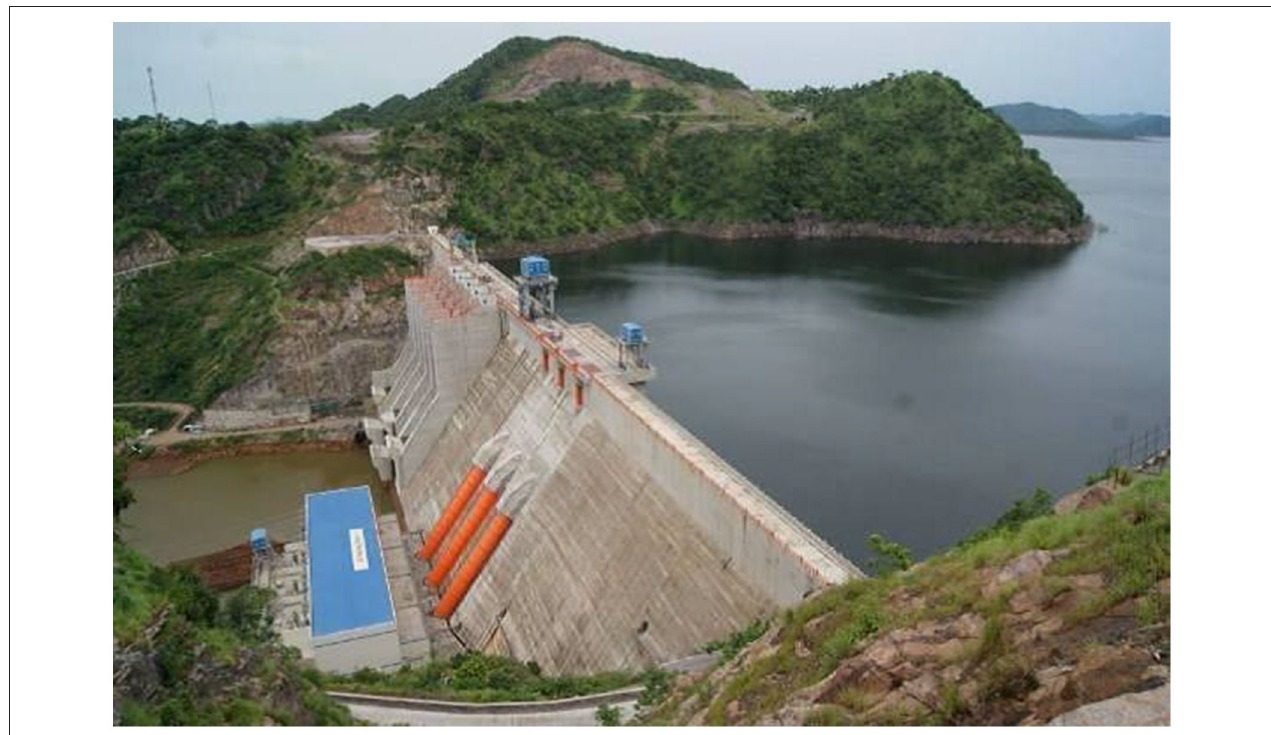
FIGURE 2 | Bui Dam in Ghana (taken by Owusu-Abedi in 2015).